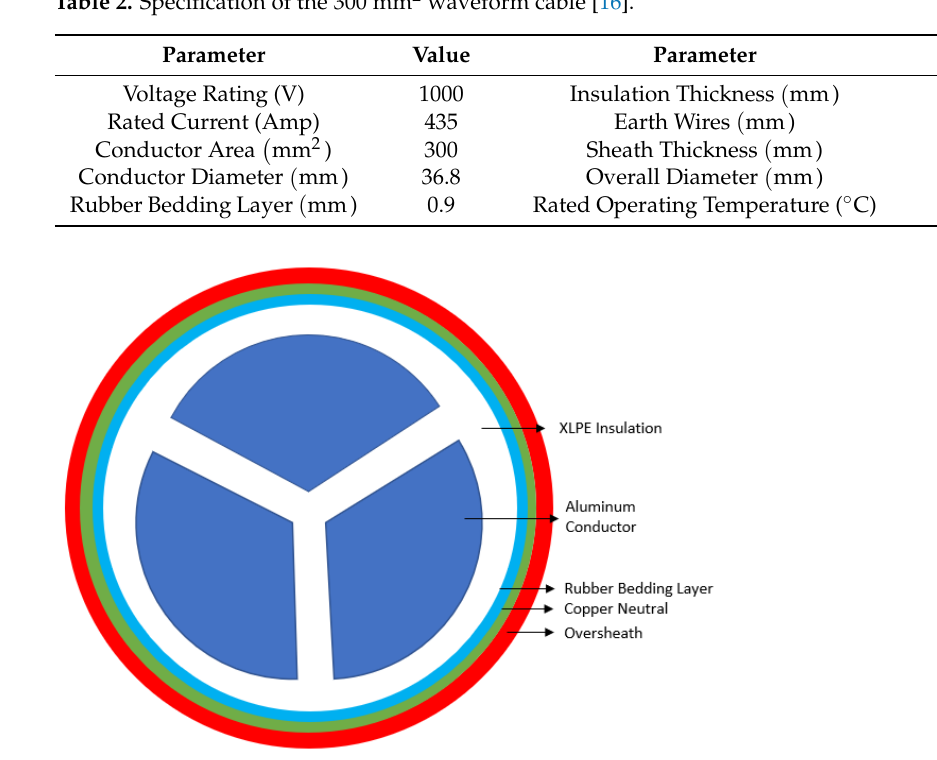
Table 2. Specification of the 300 mm 2 waveform cable [16].